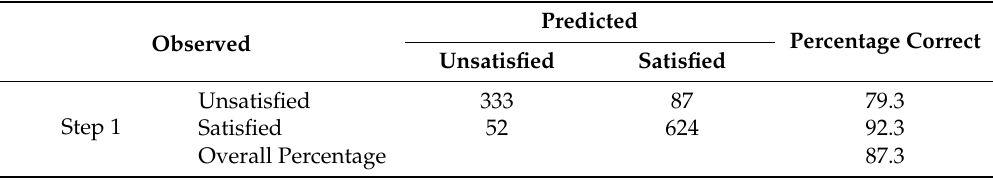
Table 3. Classification